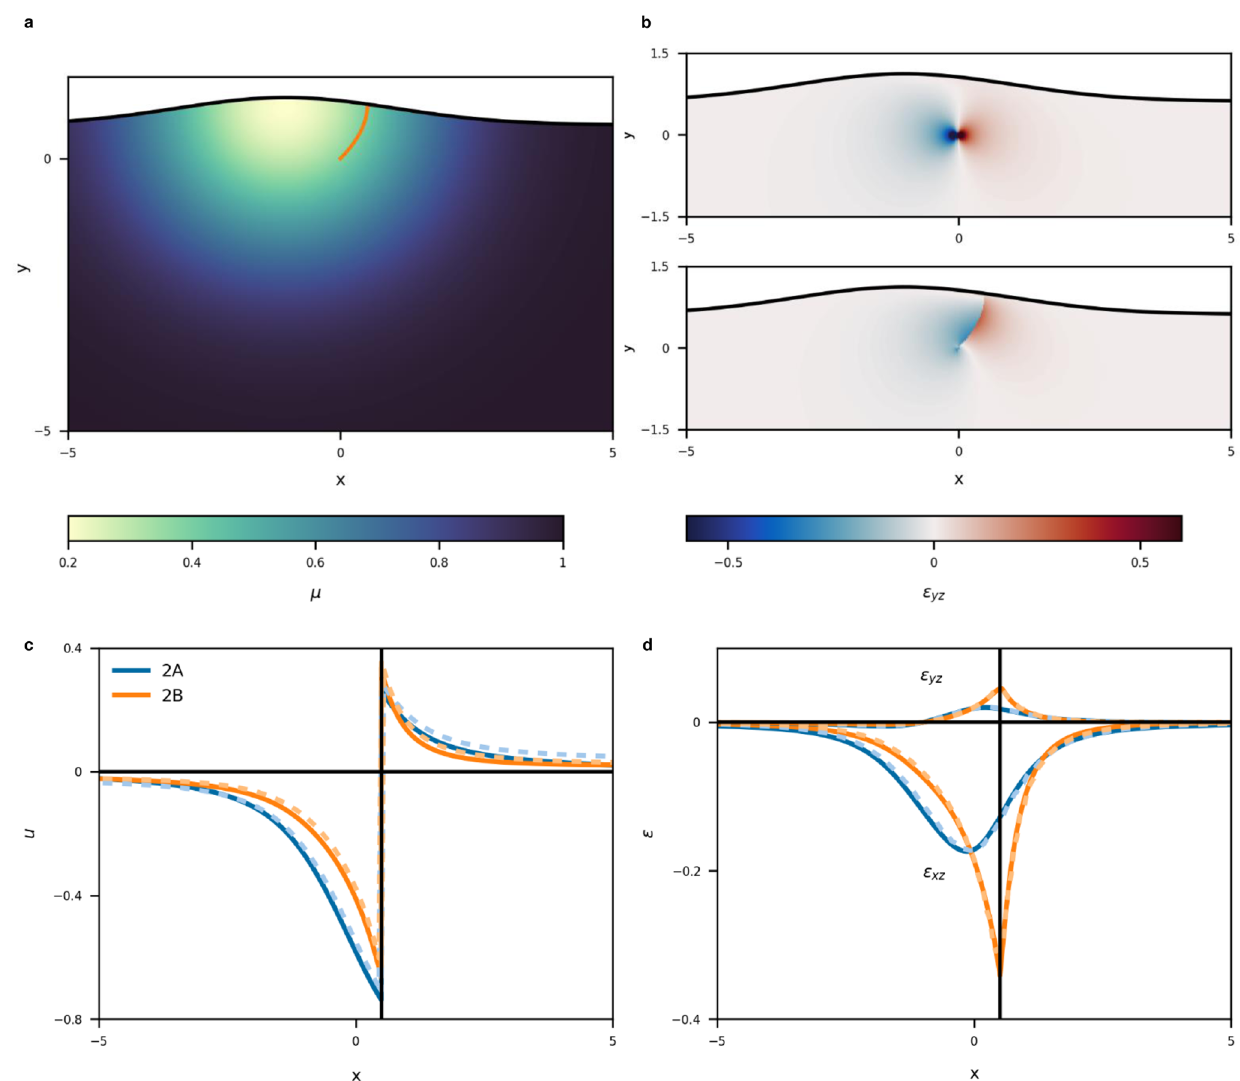
Fig. 3 | Model and estimated results of a curved, heterogeneous structure. a Model structure. Colors represent the shear modulus. The orange curve repre- sents the fault surface. b Estimated strains for Models 2A (top) and 2B (bottom).